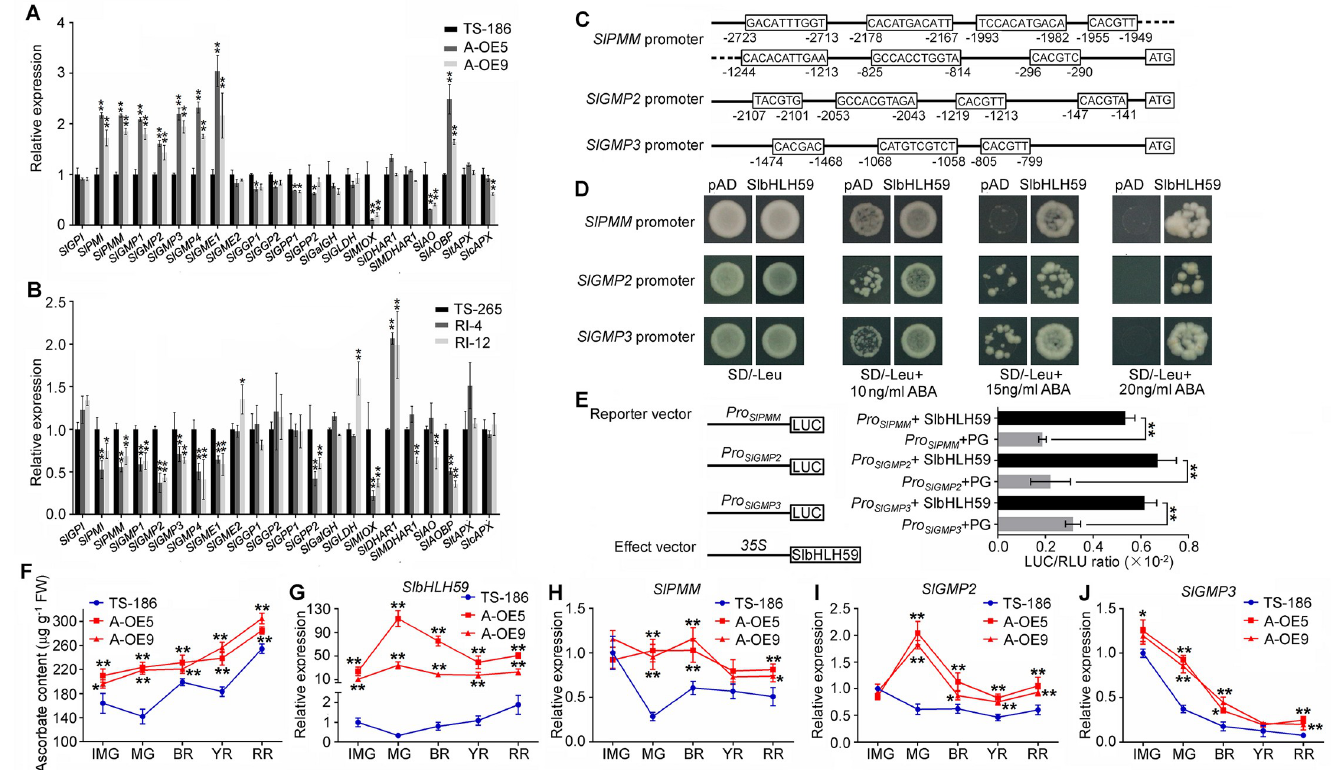
Fig 5. Identification of SlPMM , SlGMP2 and SlGMP3 as direct targets of SlbHLH59. (A, B) Relative expression of ascorbate (AsA) biosynthesis, recycling and oxidation-related genes in fruits of SlbHLH59 overexpression (A) and RNAi (B) lines. (C) The promoter cis -elements of SlPMM , SlGMP2 and SlGMP3 . The sequences in black boxes represent E-box cis -elements. (D) Yeast-one hybrid (Y1H) assay of SlbHLH59 binding to promoter fragments of SlPMM , SlGMP2 and SlGMP3 . The bait vectors SlPMM pro , SlGMP2 pro and SlGMP3 pro (the fragments containing the region 3000 bpupstream from initiation codon) and the prey vector containing SlbHLH59 were introduced into yeast strain Y187, and interaction between bait and prey enhanced ABA resistance. Yeast cells spread on SD-Leu media with various concentrations of ABA (0, 10, 15, and 20 mM). The bait vector ( SlPMM pro , SlGMP2 pro and SlGMP3 pro ) + pGADT7 were also transformed into Y187 as a negative control. (E) Binding of SlbHLH59 to promoters of SlPMM , SlGMP2 and SlGMP3 assayed by dual luciferase system. The SlbHLH59 ORF was cloned into the effector vector (pGreen II62-SK) and promoter fragments of SlPMM , SlGMP2 and SlGMP3 were inserted into the reporter vector (pGreen II 0800 LUC). Both vectors of effectors and reporters were transformed into Agrobacterium cells and used to infiltrate tobacco leaves. LUC, firefly luciferase activity; RLU, Renilla luciferase activity; PG, the empty vector of pGreenII 62-SK. The promoters of SlPMM , SlGMP2 and SlGMP3 plus PG were used as control. (F-J) Dynamics of ascorbate content and SlbHLH59 expression during tomato fruit development. Ascorbate (AsA) concentration (F) and expression of SlbHLH59 (G) , SlPMM (H) , SlGMP2 (I) , SlGMP3 (J) at different fruit developmental stages of wild-type (TS-186) and SlbHLH59 transgenic lines. Experiments were performed in immature (IMG), mature green (MG), breaker (BR), yellow ripe (YR) and red ripe (RR) fruit, respectively, with three replicates. All data in the graphs are presented as means ± SE. Asterisks indicate significant differences by t test: � P < 0.05; �� P <